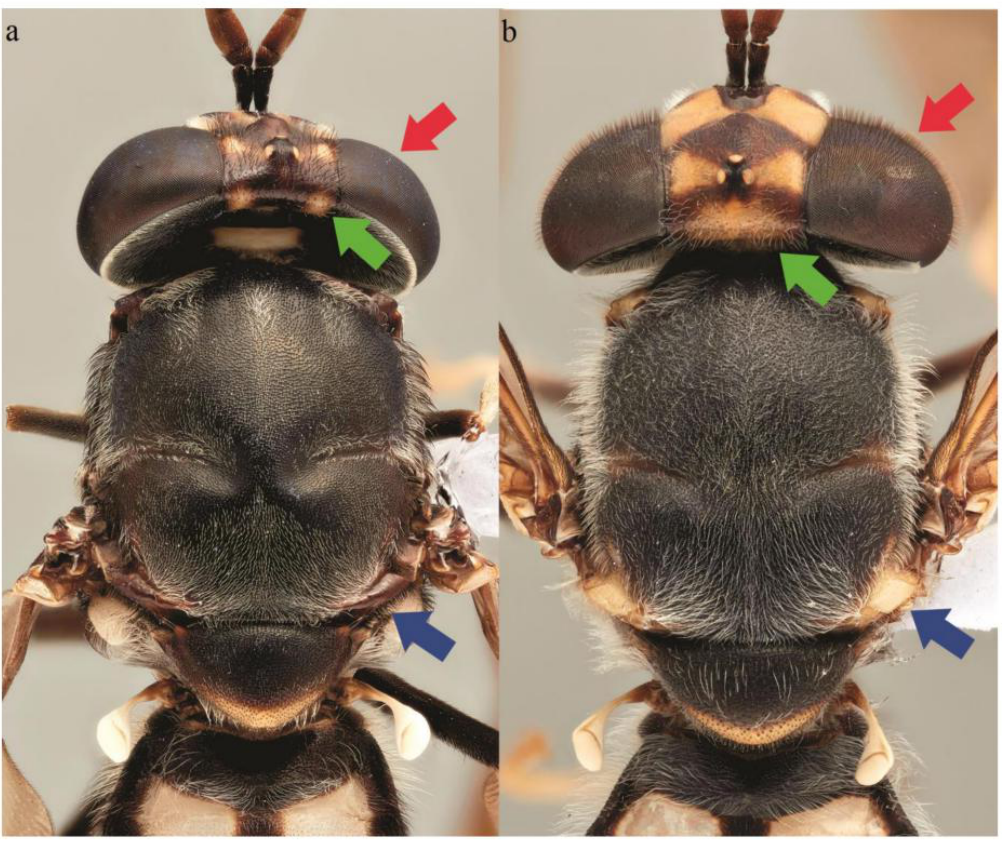
Figure 8. Detail of the thorax [green arrow (median occipital sclerite); blue arrow (postalar callus)] and head [red arrow (compound eyes)] of the adult ( a ) Hermetia illucens and ( b ) H.